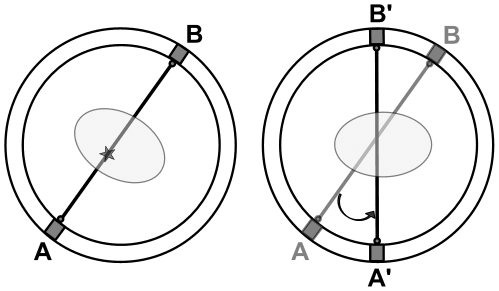
Principle of line-of-response (LOR) rebinning.A LOR represents the detected path of a pair of coincident gamma photons. The left side of the figure shows an LOR detected on the line joining detectors A and B when the object (ellipse) was in a certain (moved) pose. The right side shows the original object pose, and indicates how the LOR ought to be reoriented so as to correctly coincide with this pose i.e. it now lies on A′B′. Notice that in both cases the path through the object is the same. Although shown here in 2D, the transformations are 3D in general.